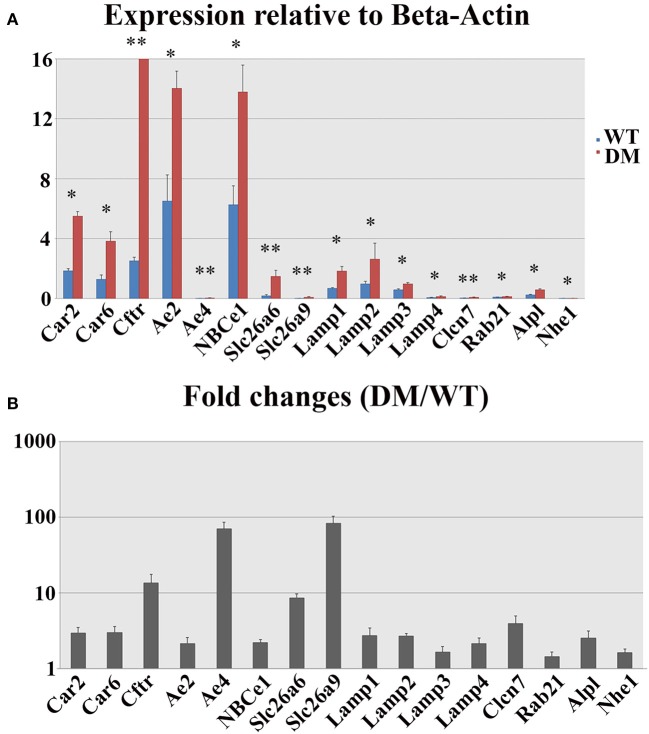
Realtime PCR analysis of gene expression in wild-type and double-mutant maturation enamel organs. WT, Wild-type; DM, Double-mutant. (A) Relative expression values normalized to that of Beta-Actin. (B) Fold changes. Significant upregulation was detected for all the genes quantified (DM/WT). Ae4 and Slc26a9 showed most striking fold changes—~70.5 and ~83.0%, respectively. The fold changes for the remaining genes were all above 2, except for Lamp3, Rab21, and Nhe1. *P < 0.05; **P < 0.01.